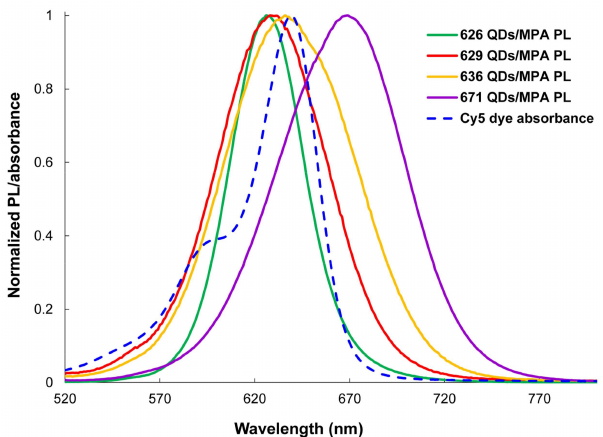
Figure 4. Spectral overlap of the donor MPA-capped CdTeSe QDs emissions and the acceptor Cy5 dye absorption. The solid lines represent the emission spectra of the donors ( λ em = 626, 629, 636, and 671 nm) and the dotted line represents the absorption spectrum of the Cy5 dye ( λ em = 639